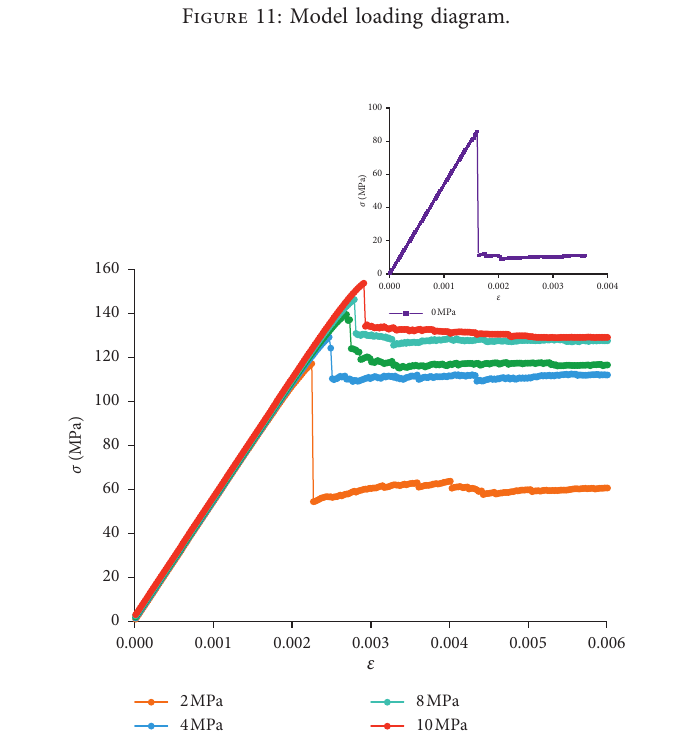
Figure 11: Model loading diagram.